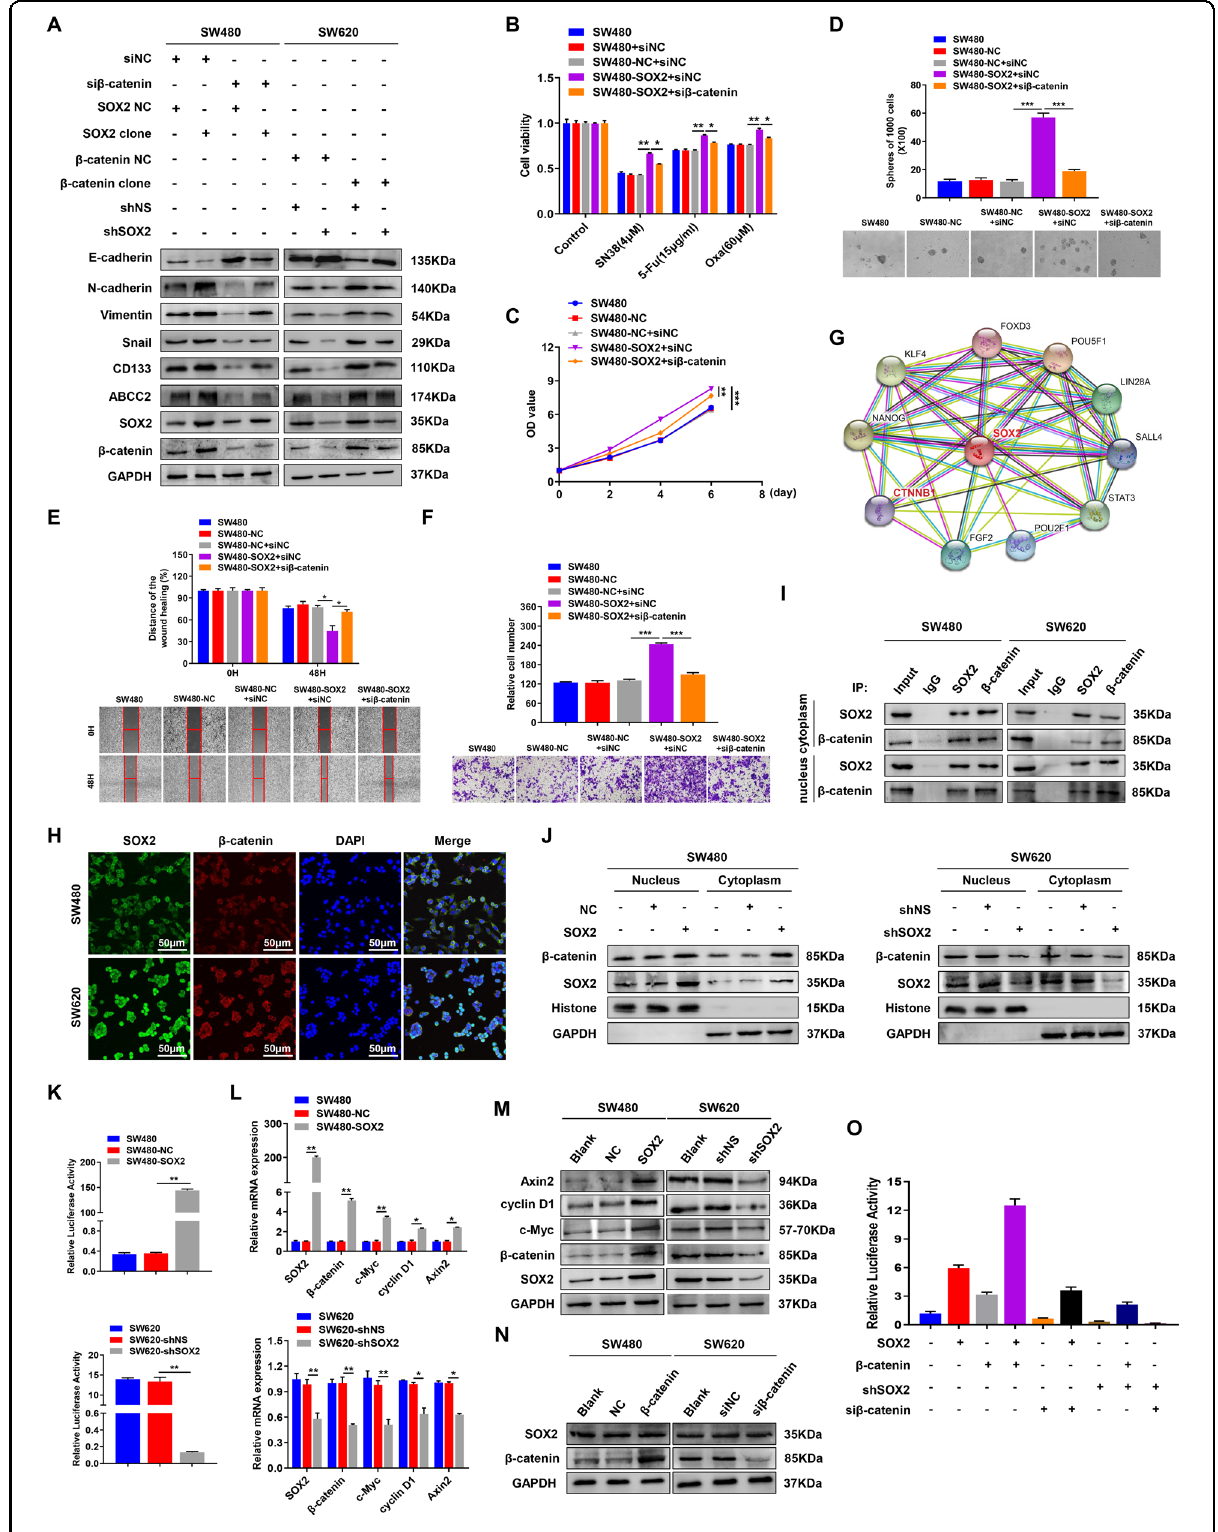
Fig. 2 (See legend on next